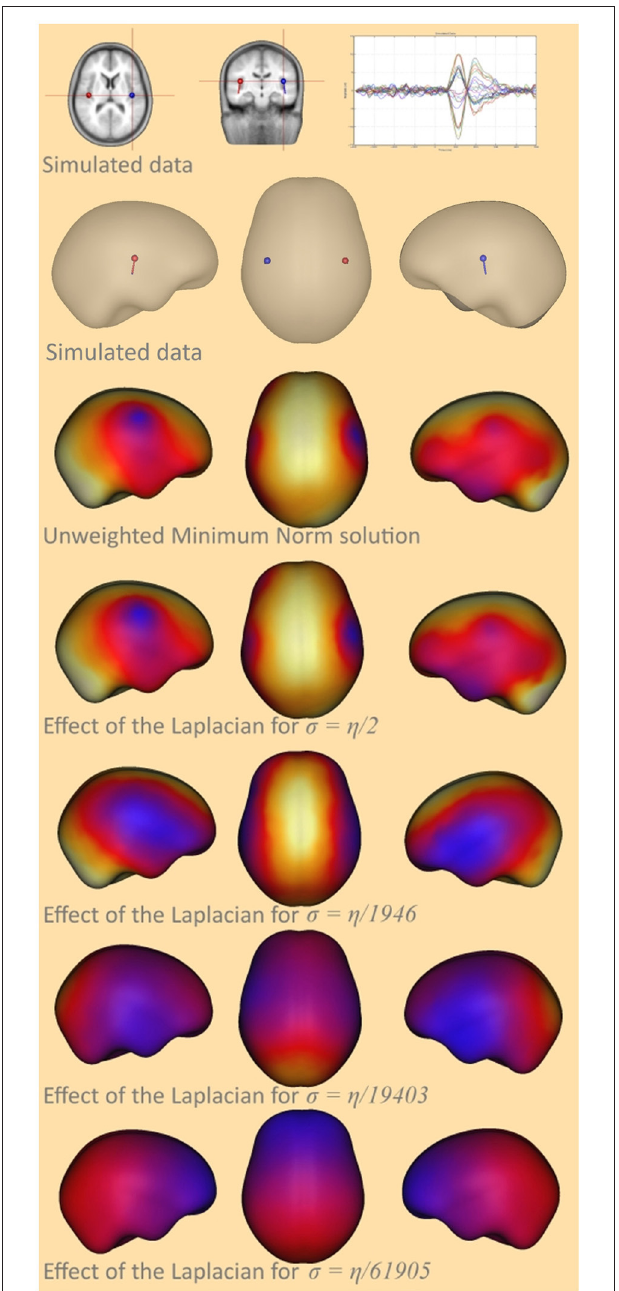
FIGURE 2 | Smoothing effect of the surface Laplacian. The top-most row and the second row show the simulated auditory sources together with a butterfly plot of the signal created at the sensors, the third row shows the unweighted minimum-norm solution, the fourth row the cortical LORETA solution for σ = 65, the fifth row for σ = 6.7e-2, the sixth for σ = 6.7e-3, and the bottom-most row shows the cortical LORETA solution for σ = 2.1e-3.